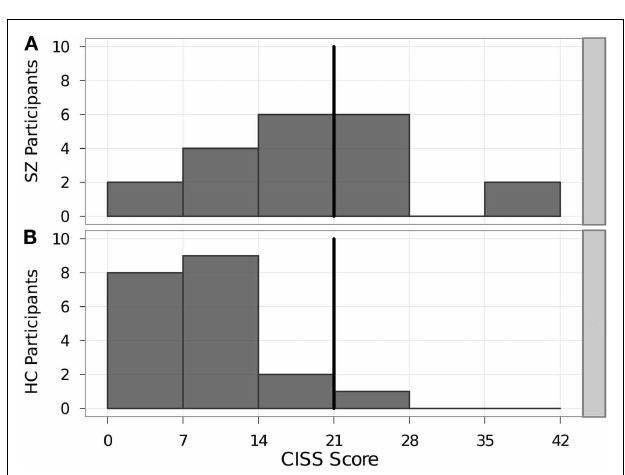
FIGURE 1 | Distribution of mean CISS scores in each participant group. Bold vertical line indicates the cutoff score of 21. Individuals scoring ≥ 21 on the CISS were considered as having symptoms consistent with CI. (A) SZ, schizophrenia patients. (B) HC, healthy controls. CISS, Convergence Insufficiency Symptom Survey.